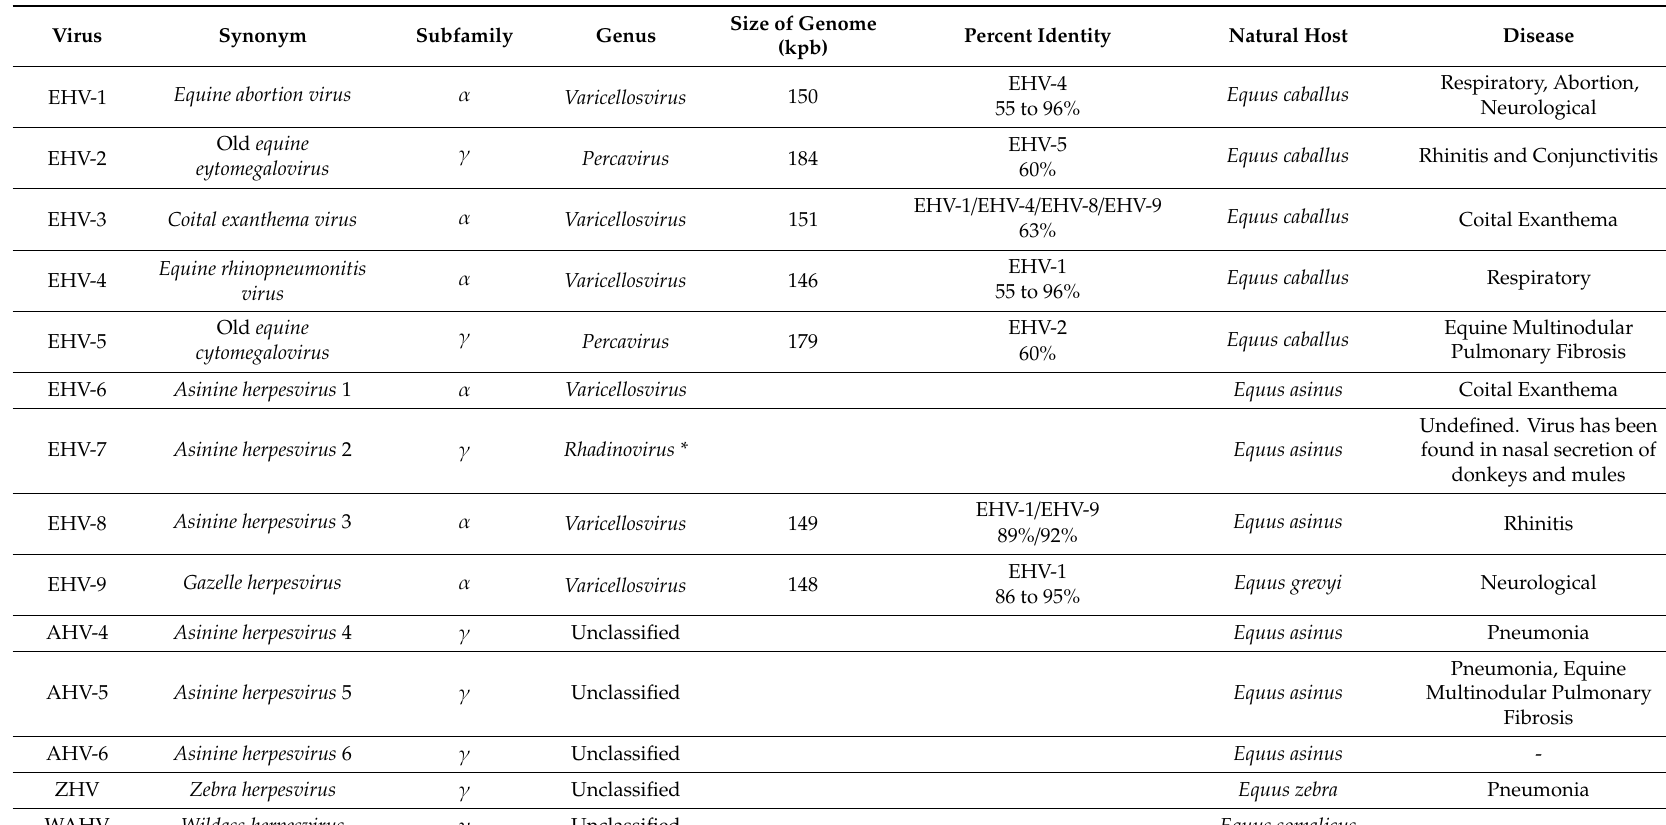
Table 4. A list of Herpesviruses that infect the family